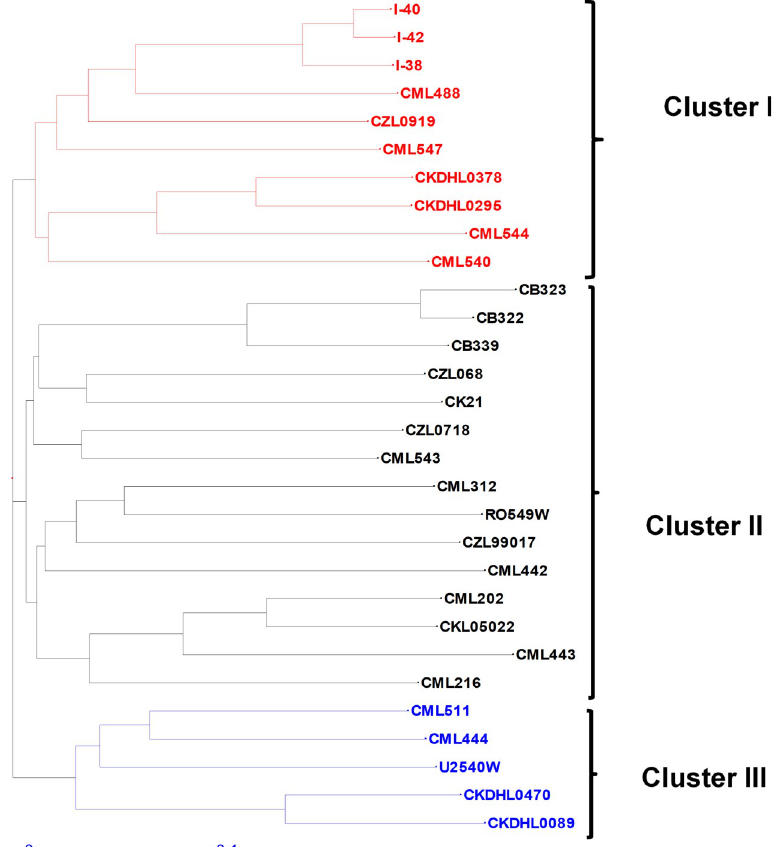
Fig 2. Neighbor-joining dendrograms based on UPGMA genetic dissimilarity depicting the genetic relationship between 30 parental maize lines based on 92 SNPs.